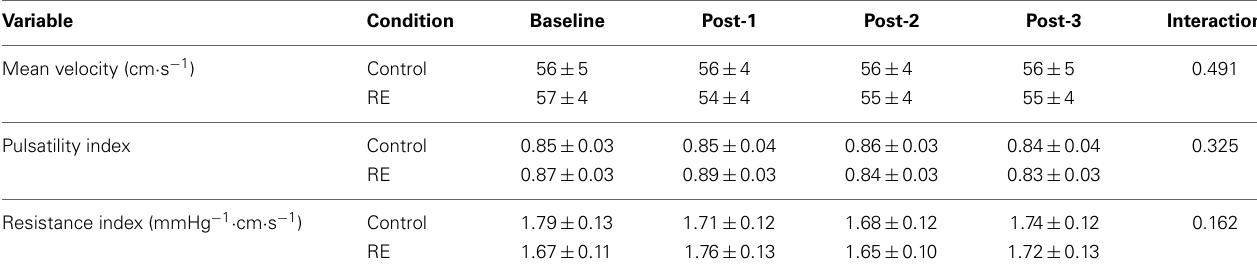
Table 5 | Cerebral variables across testing time points between control and resistance exercise ( n =